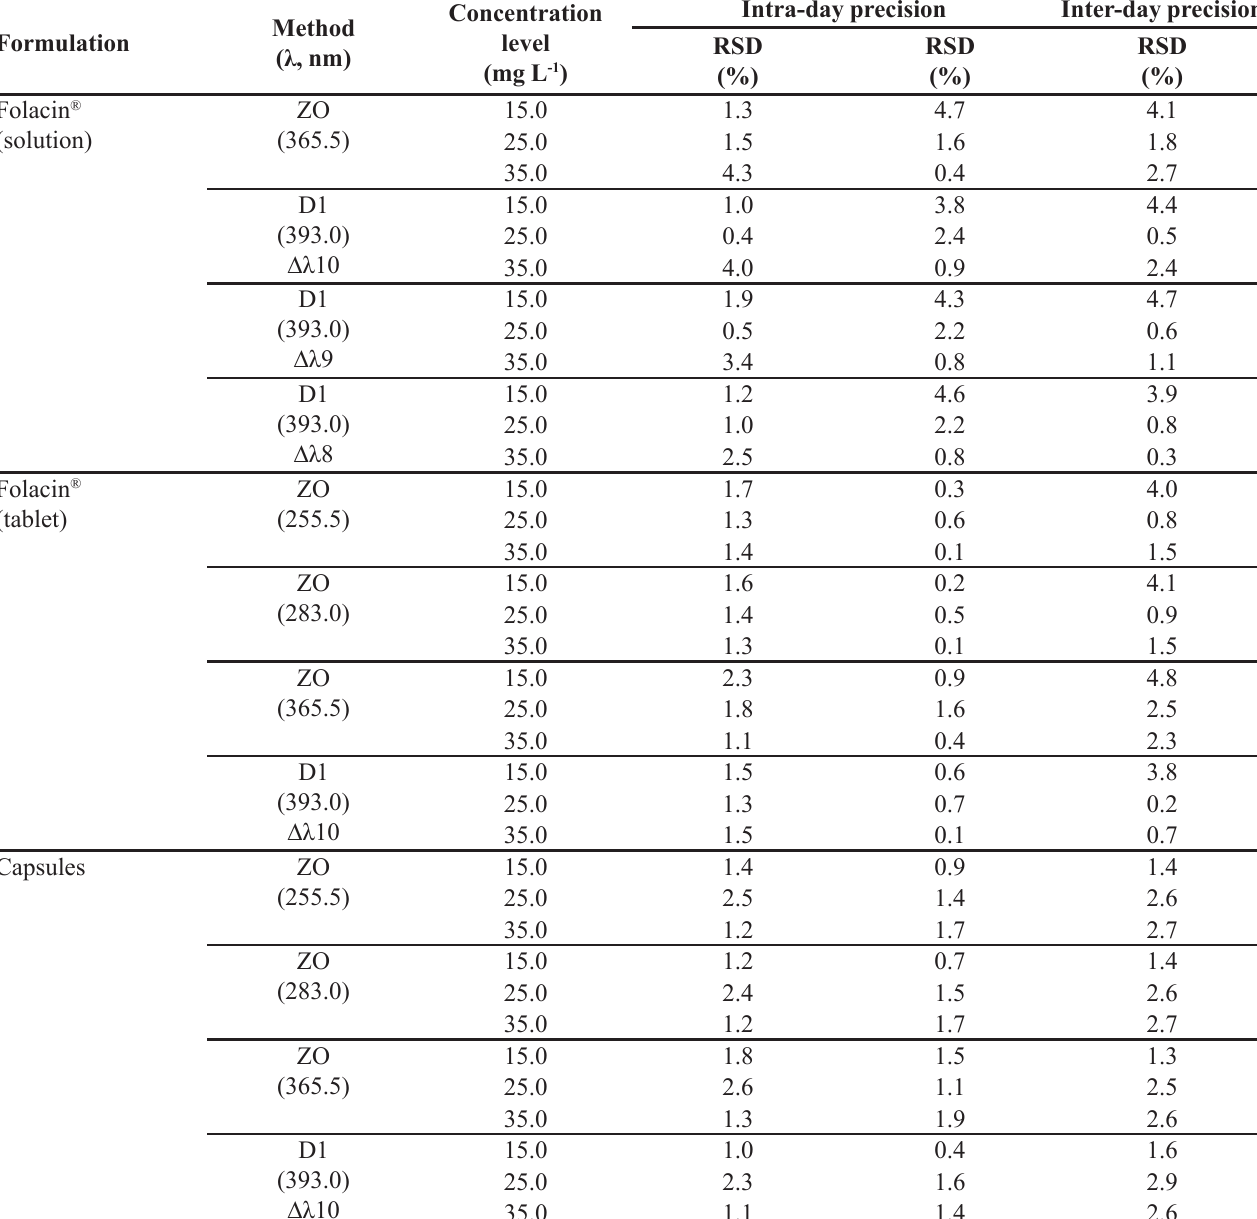
TABLE III - Intra-day and inter-day precisions for the proposed methods